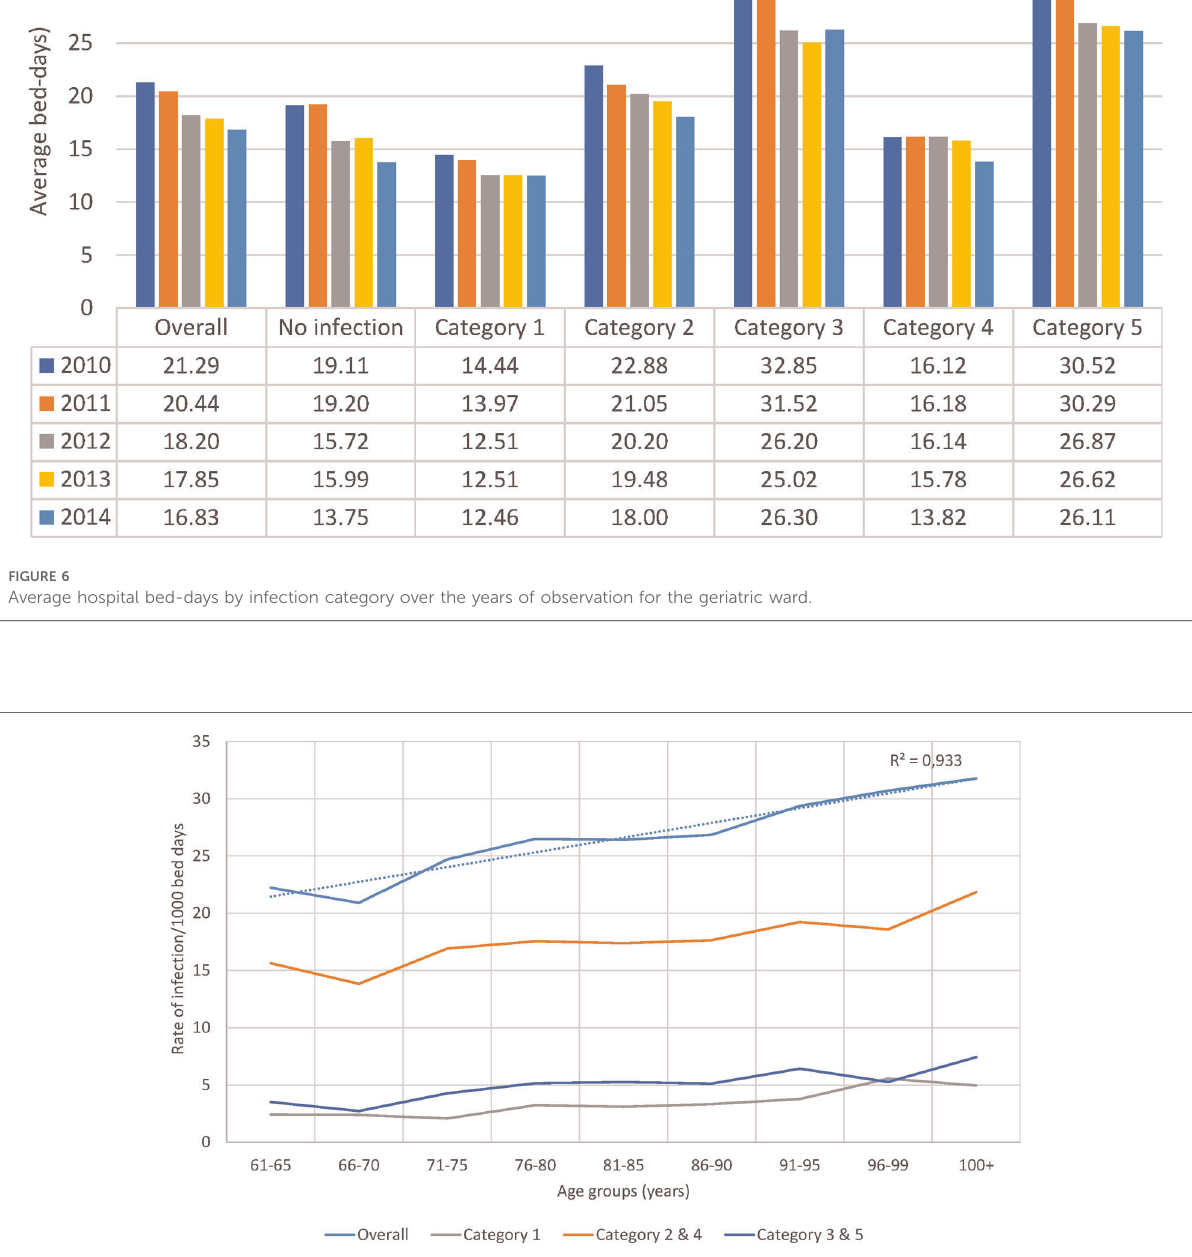
FIGURE 7 Infection rate overall and for the different infection categories per 1,000 bed-days occupied during the observation period (2010 – 2014) by age group in the geriatric